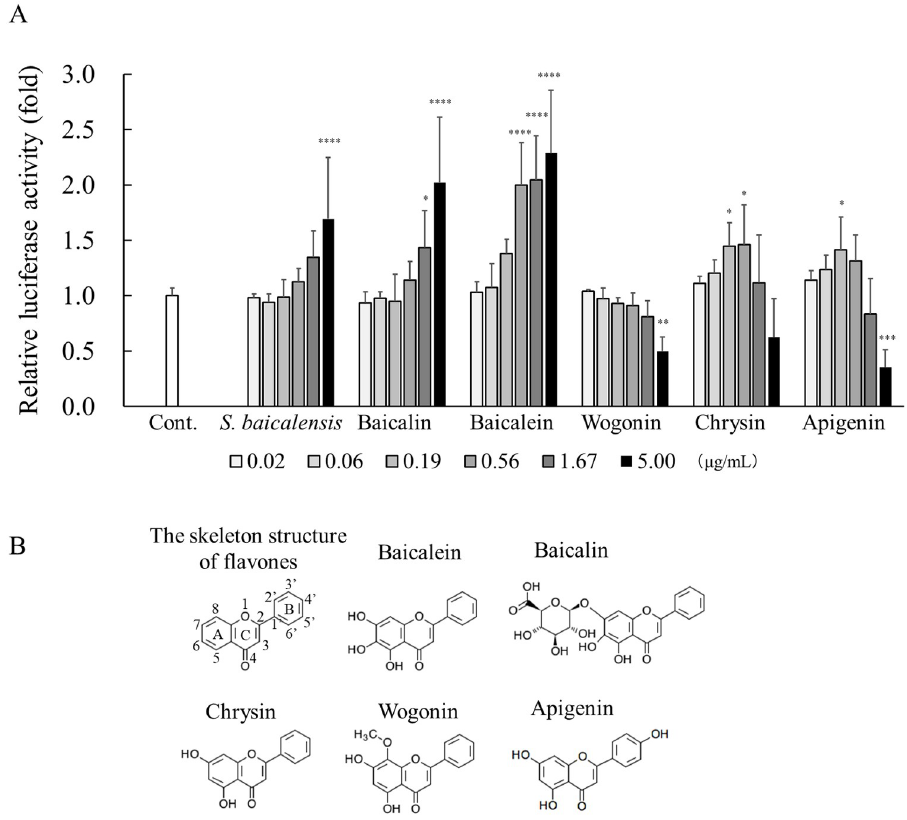
Fig 5. Effects of S . baicalensis –derived compounds on Sema3A reporter gene expression. (A) NHEKs were transfected with pGL3- Sema3A vector. After transfection, the cells were incubated with S . baicalensis extract and S . baicalensis -derived compounds: apigenin, baicalein, baicalin, chrysin, and wogonin, at the indicated concentrations, a 3-fold dilution with a maximum concentration of 5 μ g/mL, for 24 hours at 37˚C. Cell lysates were subjected to the measurement of luciferase activities as described in the Materials and methods. All results are expressed as means ± S.D. of three independent experiments. � p < 0.05, �� p < 0.01, ��� p < 0.001, ���� p < 0.0001 (one-way ANOVA followed by Dunnett’s test). (B) Chemical formulae of major bioactive flavones from S . baicalensis